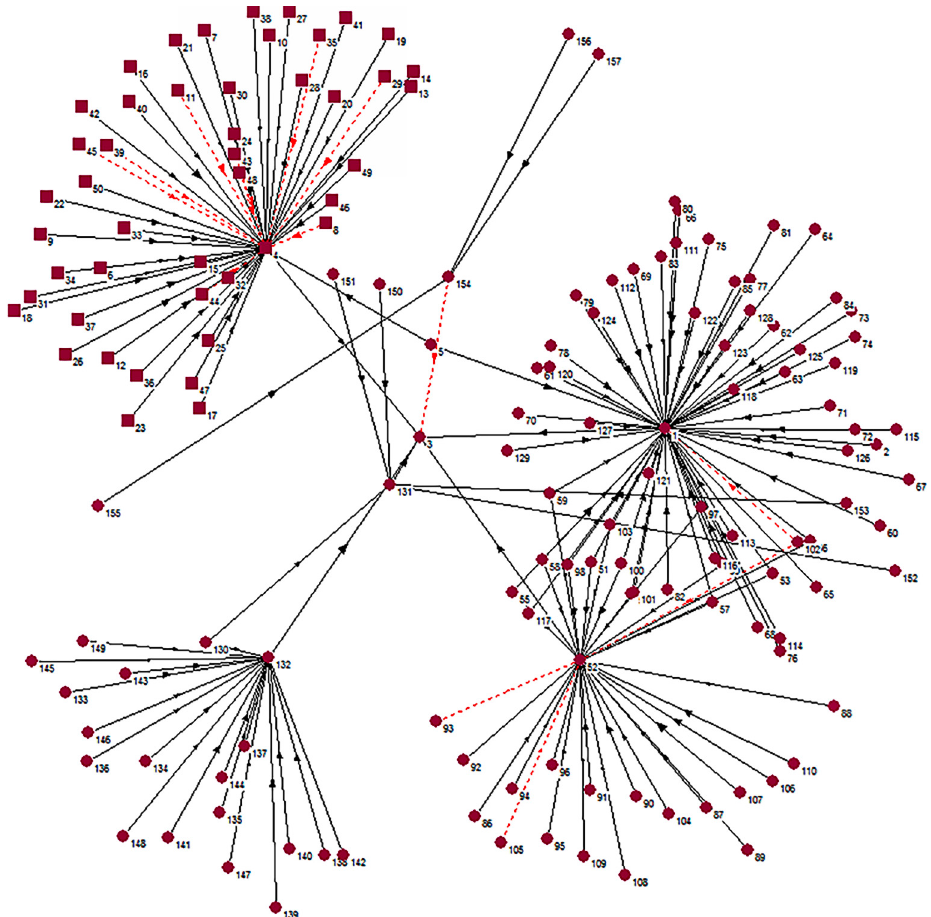
Fig. 4. Basic structure of the